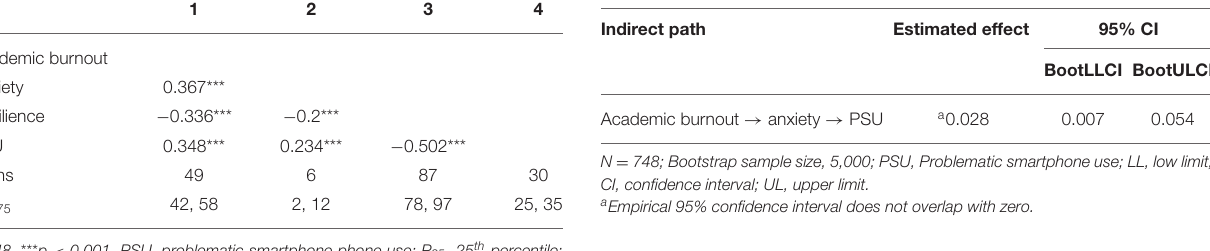
TABLE 3 | Bootstrapping indirect effect and 95% confidence interval (CI) for the mediation